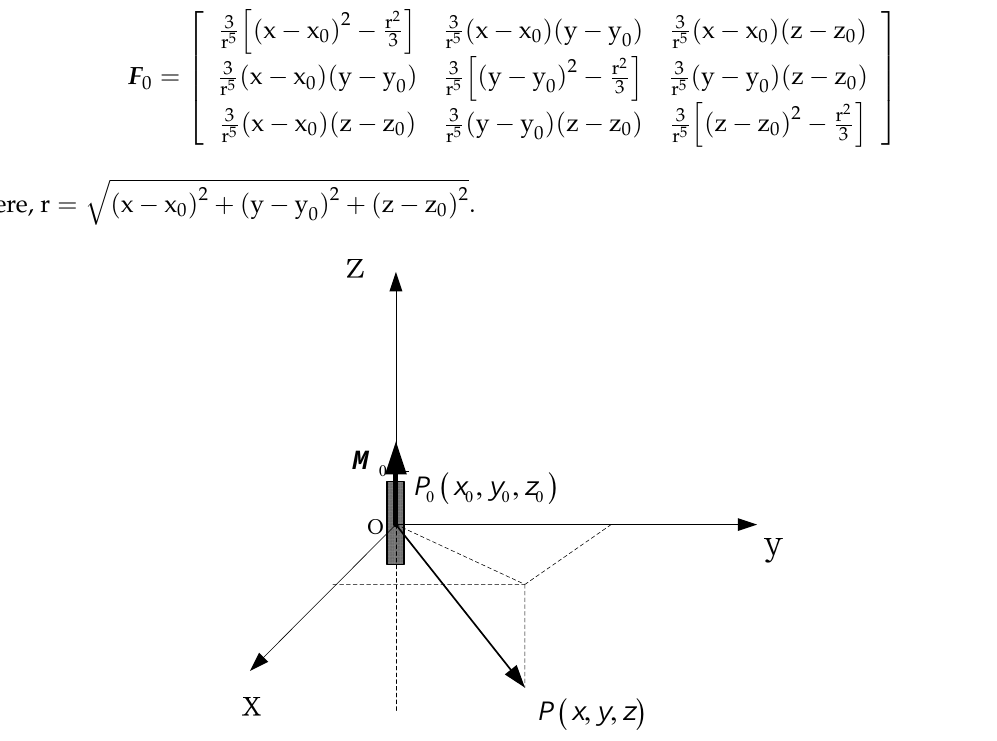
Figure 2. Coordinate of relative position between target and sensor.